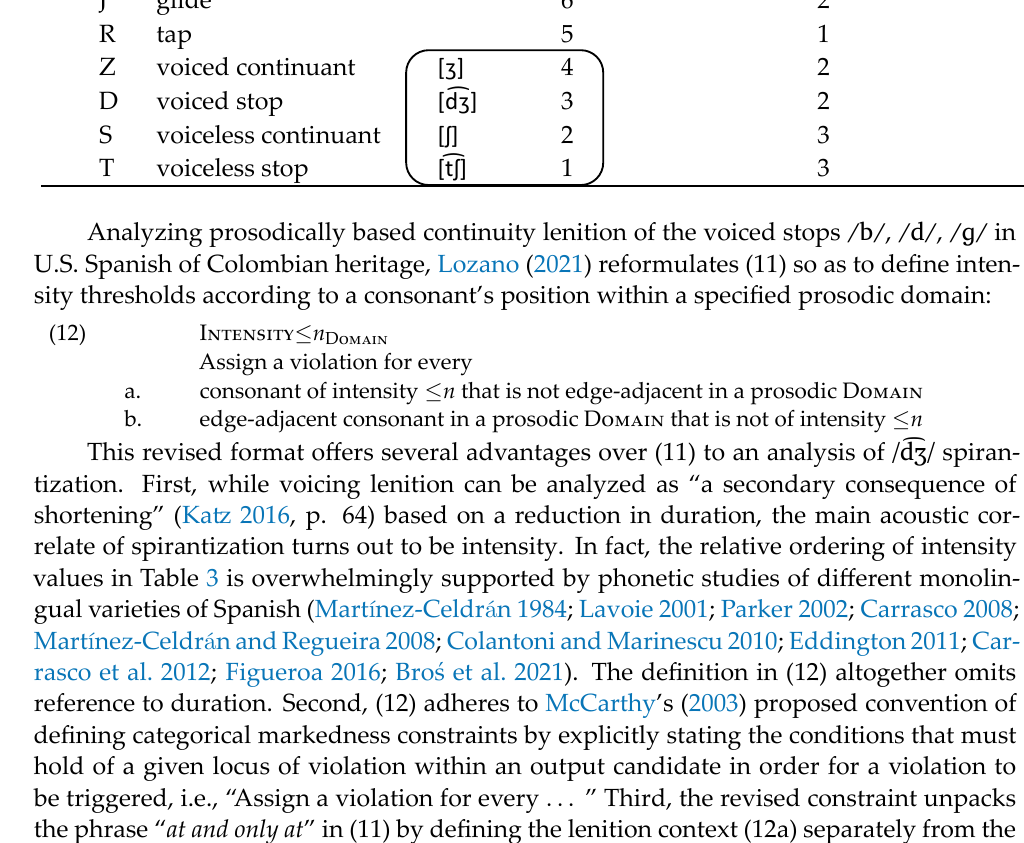
Figure 1. Domains of the prosodic hierarchy, showing only the Prosodic Word and above (adapted from Bonet 2020, p. 333; see also Selkirk 1978, 1984, 1986; Nespor and Vogel 1986).